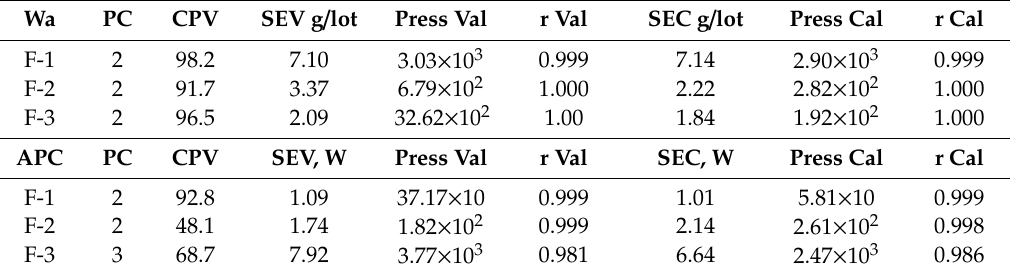
Table 2. The chemometric parameters for the fitted calibration models to measure the added water amount and the agitation power consumption